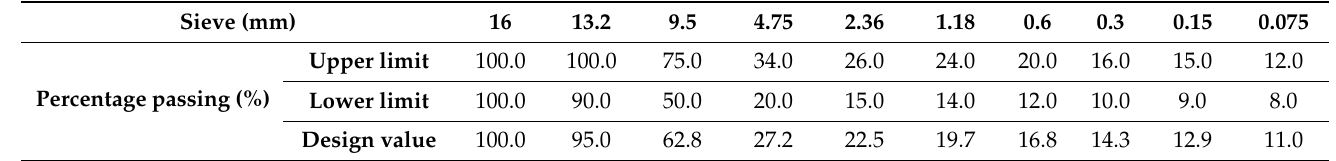
Table 5. Aggregate gradation of SMA-13.